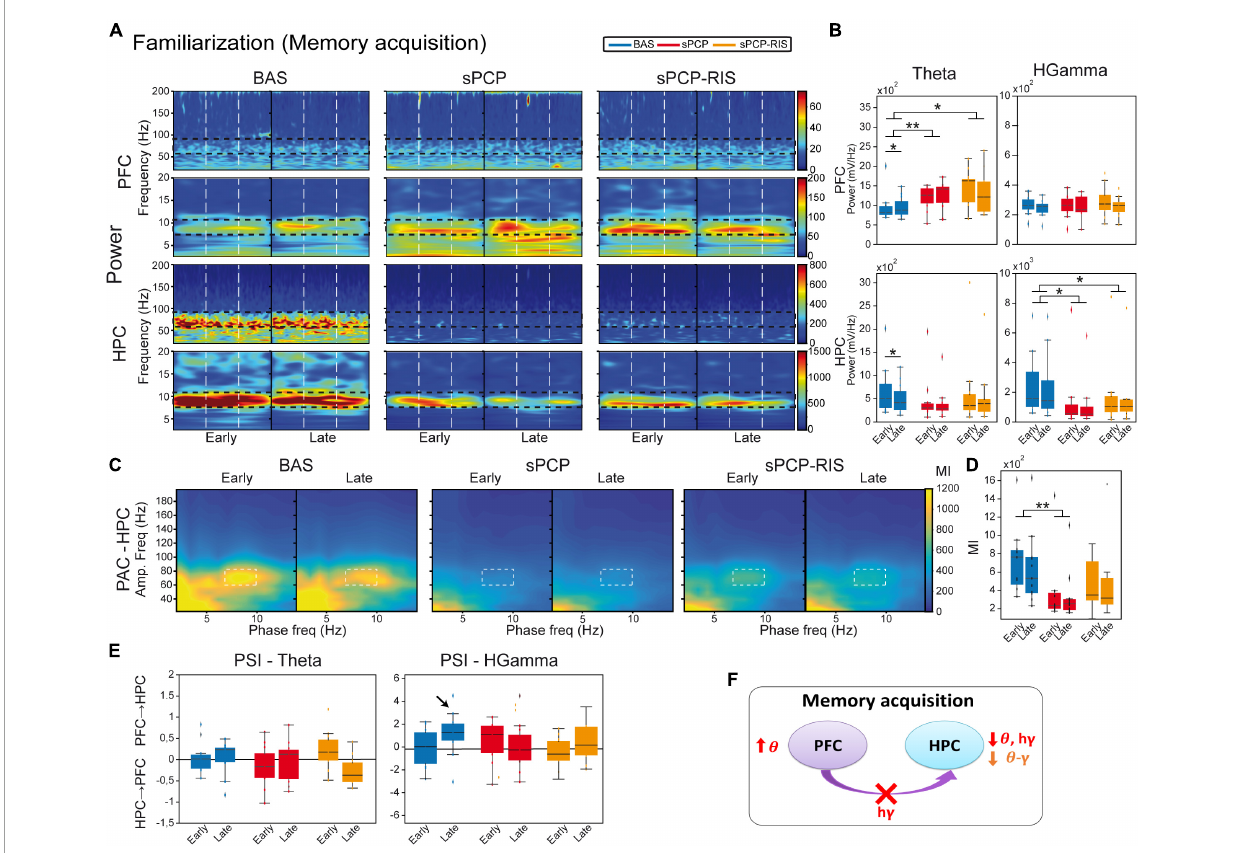
FIGURE3 Neural substrates of memory acquisition and effects of sPCP and risperidone. (A) Power spectra showing the effects of sPCP and risperidone in the mPFC and the dHPC during the familiarization phase. Vertical dashed lines mark the first second upon initiation of the visits. (B) Prefrontal theta power increased in healthy animals during the late visits to the objects. sPCP increased non-specifically theta power in the mPFC (baseline vs. sPCP: F ( 1 , 10 ) = 7.46, p = 0.021; mixed ANOVA with time of visits (early vs. late) and treatment (baseline vs. sPCP) as factors) and reduced theta and high gamma power in the HPC (baseline vs. sPCP: F ( 1 , 12 ) = 4.81, 9.59, p = 0.053, 0.011), disrupting the normal neural dynamics of memory acquisition. Risperidone did not rescue these power changes. (C,D) Intrinsic dHPC theta-gamma coupling (7–10 Hz with 60–80 Hz) did not change